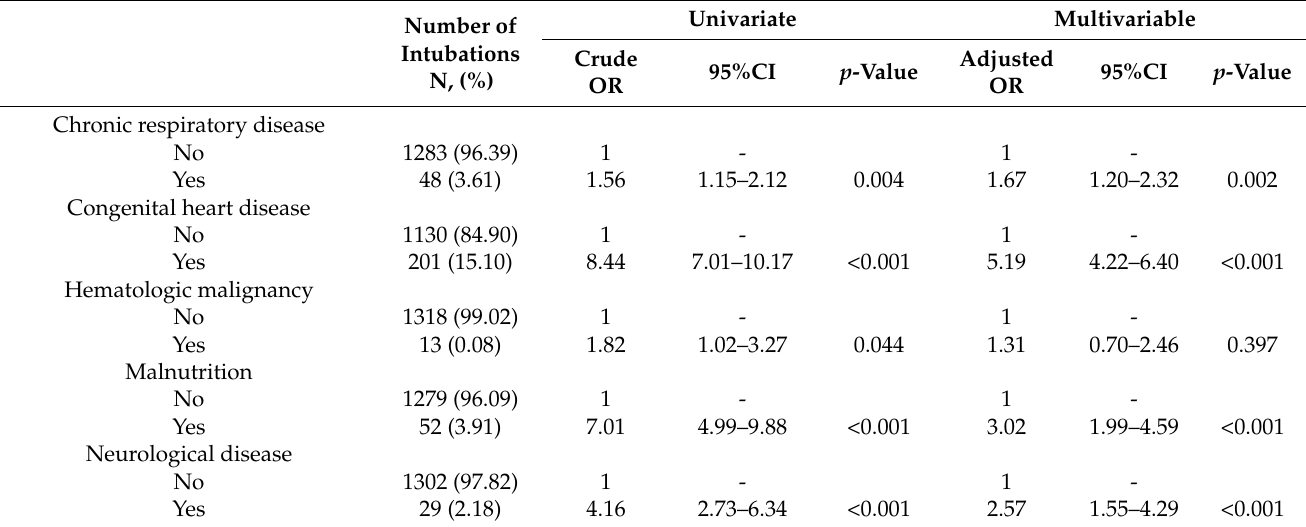
Table 4. Factors associated with respiratory failure requiring endotracheal intubation among hospi- talized children with RSV-related LRTI.